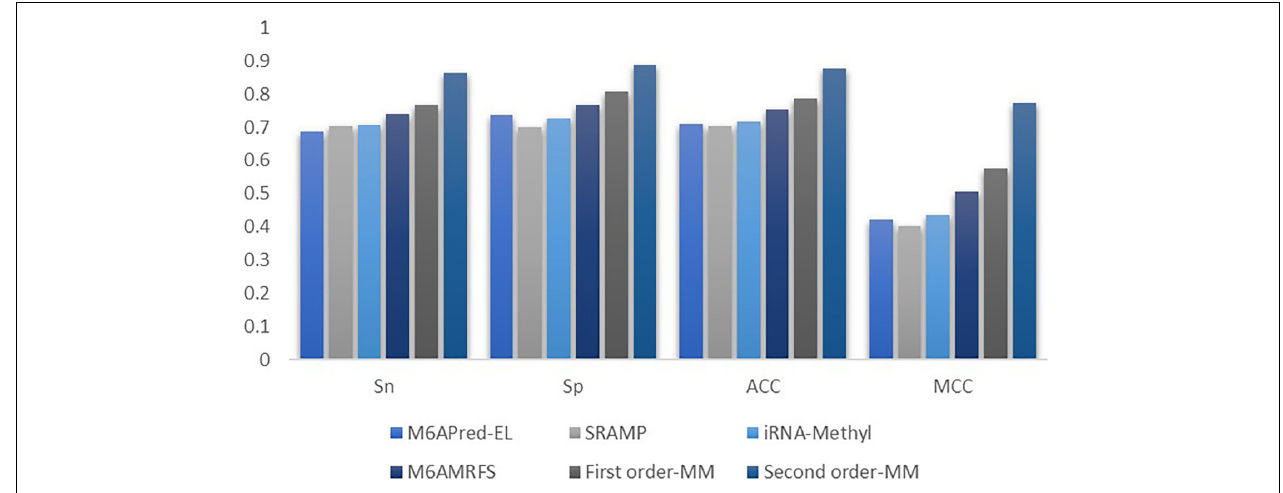
FIGURE 5 | Comparison of the prediction effect of m6A in mice based on the m6Avar database.